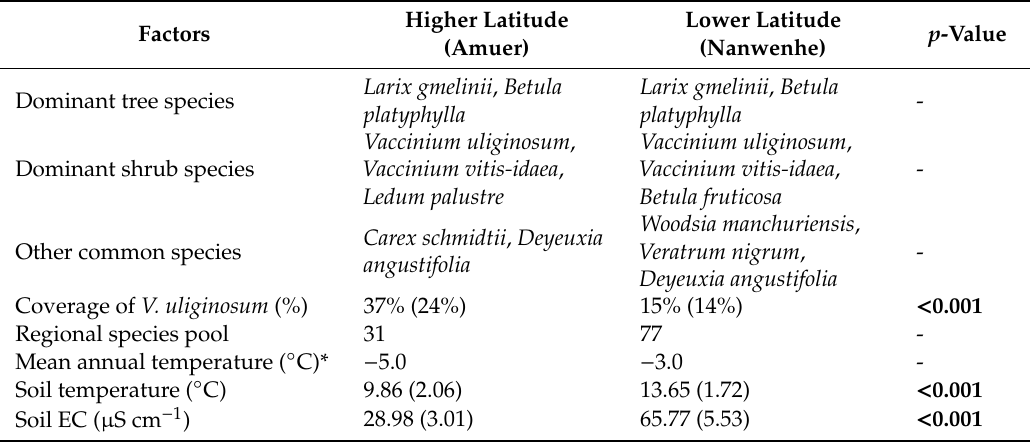
Table 2. Vegetation characteristics and soil properties of boreal forests at higher and lower latitudes.